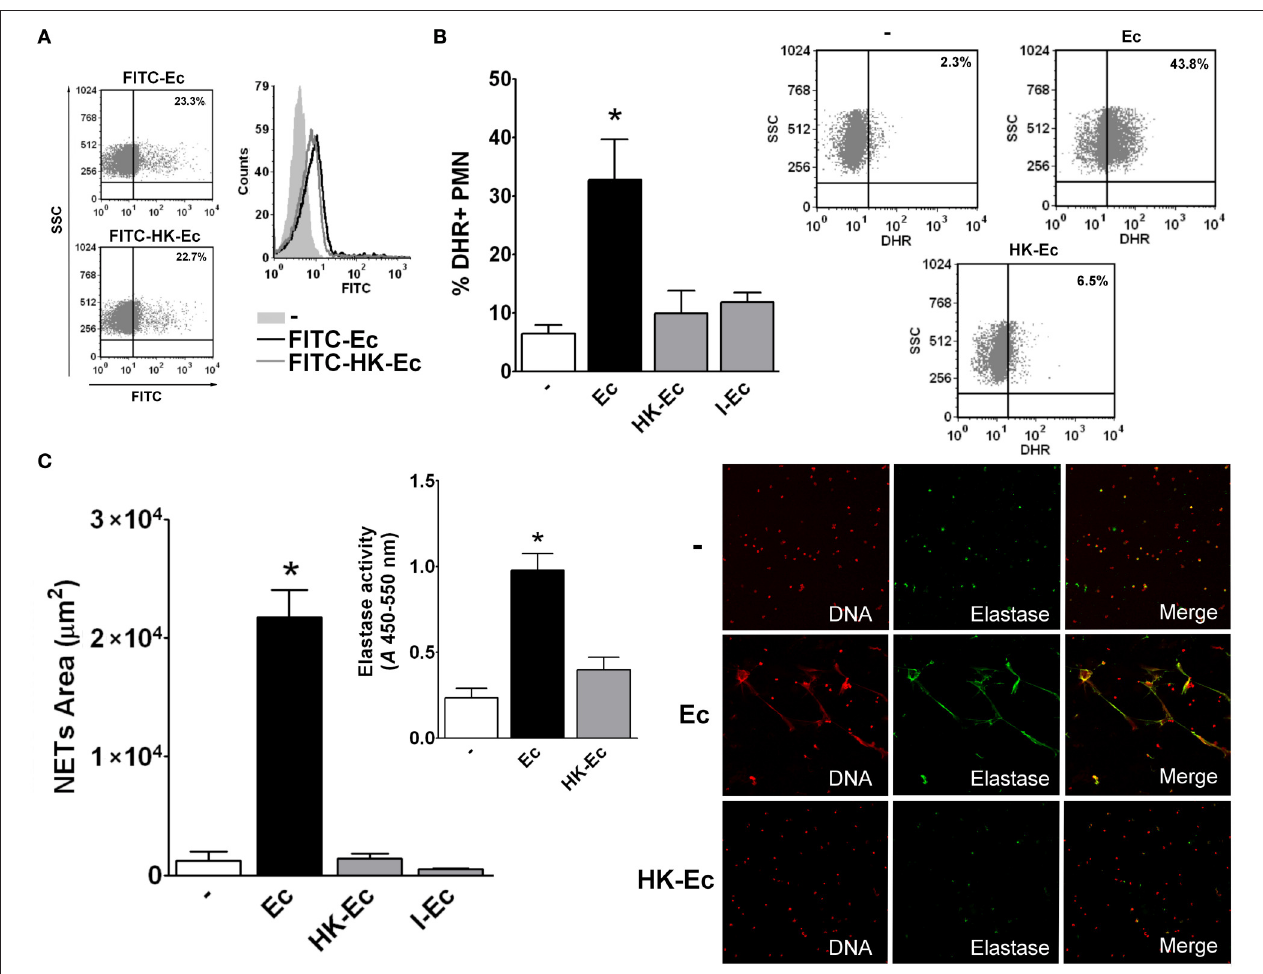
FIGURE 2 | Live bacteria is critical for triggering bactericidal responses. (A) Phagocytosis of FITC-Ec or FITC-HK-Ec was determined after 60 min by flow cytometry. Dot plots showing the percentage and a histogram showing the MFI of FITC + PMN of a representative experiment out of three are depicted. (B) ROS generation. Isolated PMN were stained with DHR for 15 min and then treated with Ec, HK-Ec, or I-Ec in a PMN:bacteria ratio of 1:20 for 30 min. The % of DHR + PMN was determined by flow cytometry. Results were expressed as the mean ± ES, n = 8. Right panel : Representative dot-plots of the percentage of DHR + PMN are shown in non-treated ( − ), Ec and HK-Ec-treated PMN. (C) Isolated PMN were incubated with Ec, HK-Ec, or I-Ec in a PMN:bacteria ratio of 1:20 for 3 h and NETs were stained with propidium iodide for DNA and with a specific antibody for elastase detection and were visualized by confocal microscopy. NETs area ( µ m 2 ) was measured using the FIJI software as described in material and methods. Results were expressed as the mean ± ES, n = 10. Inset: Elastase activity using a specific substrate was determined and the absorbance ( A ) at 450–550 nm is depicted for untreated PMN ( − ) and PMN treated with Ec or HK-Ec. Results were expressed as the mean ± ES, n = 10. Right panel : Representative microphotographs of confocal images showing PMN from the untreated ( − ), Ec and HK-Ec groups stained for DNA or elastase visualization and the merge of the images (x200). In all cases * p < 0.05 vs. all other